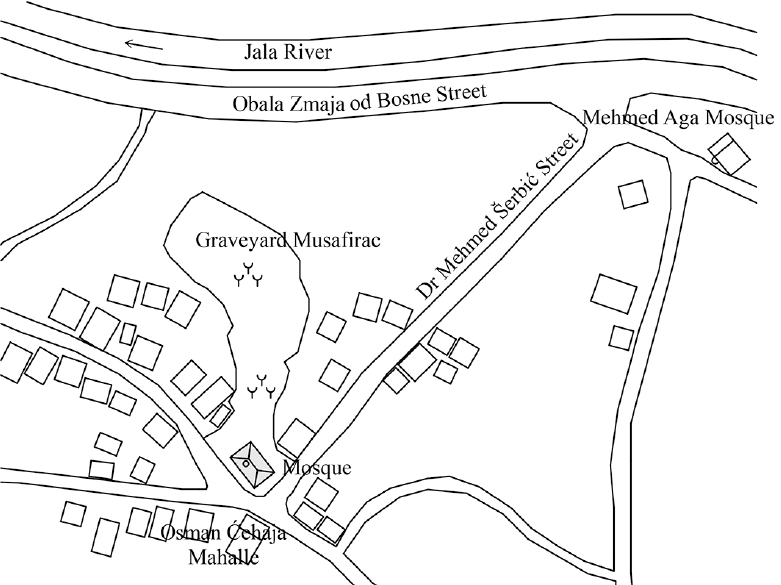
Figure 1. Map of the Mahalla of Osman Ćehaja in Tuzla (drawings by the